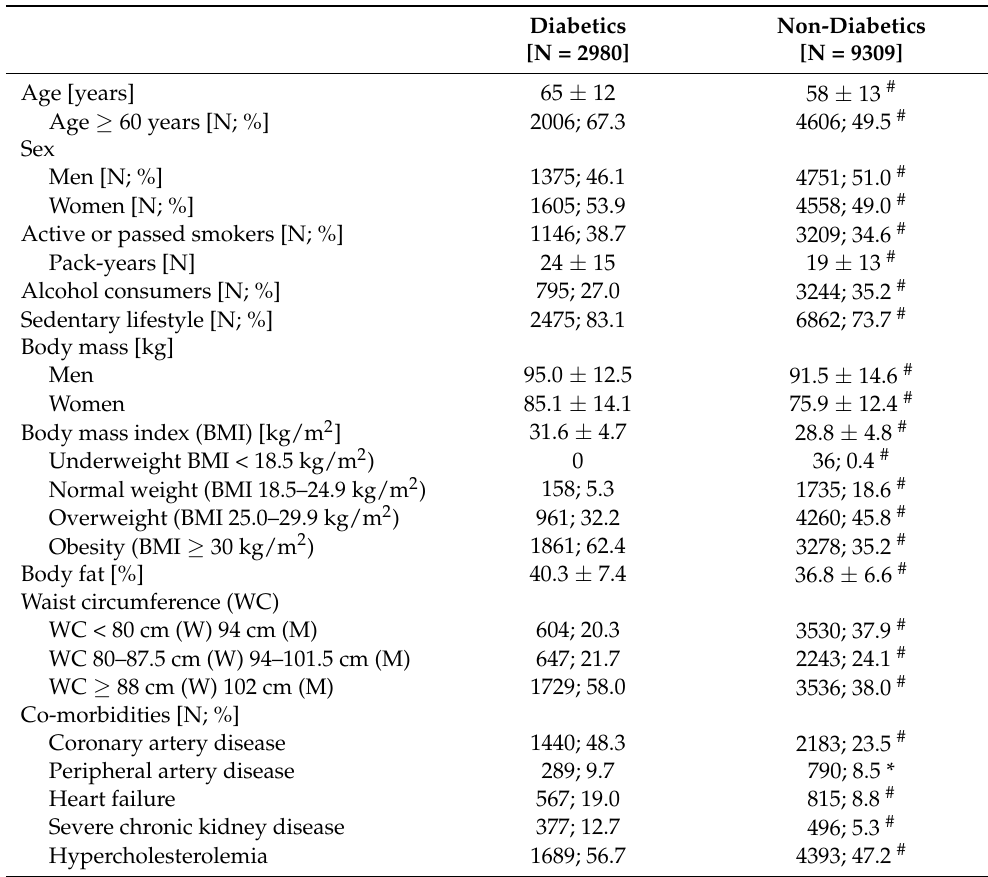
Table 2. Comparison of patients with and without diabetes.